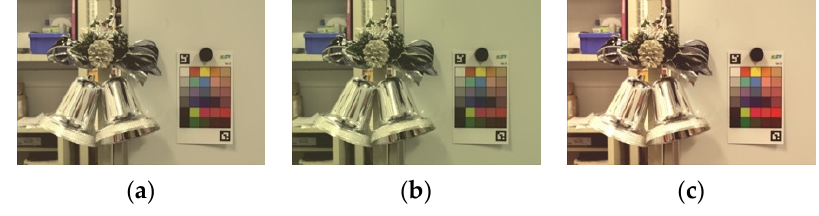
Figure 4. Color matching images. ( a ) iPhone7; ( b ) Xperia1; ( c ) FireHD8.